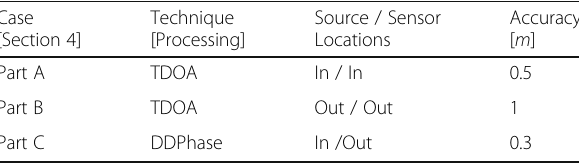
Table 2 Direction-finding measurement techniques